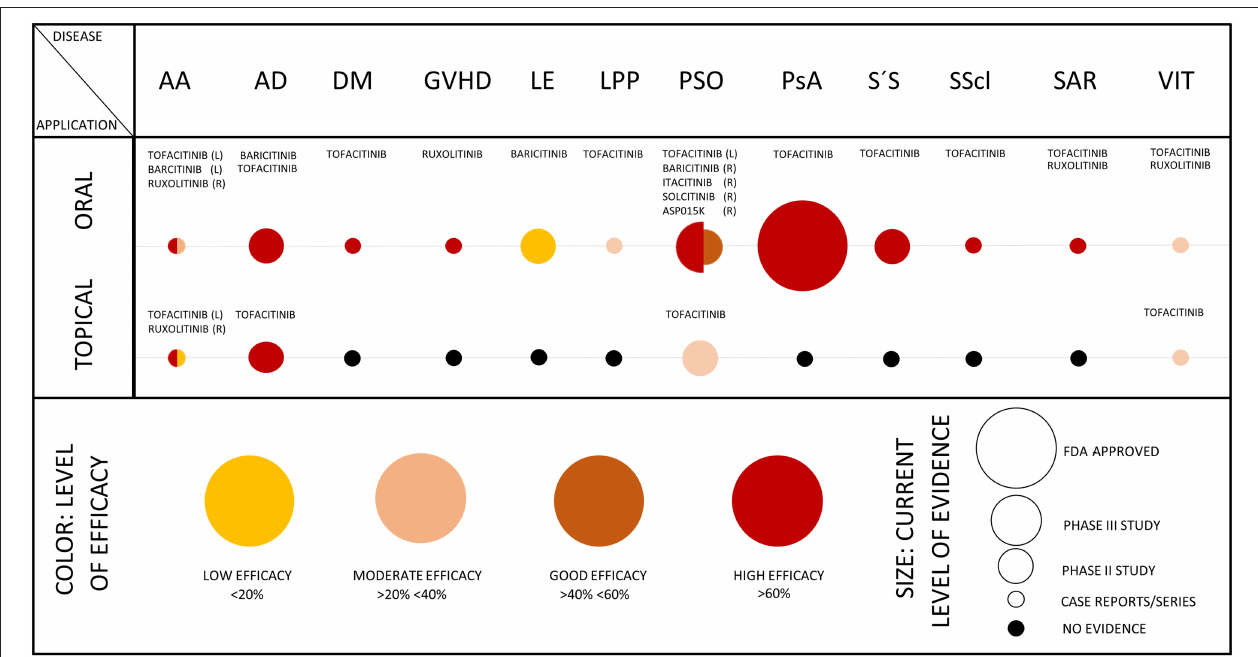
FIGURE 3 | Efficacy of JAKi in dermatology. The scheme summarizes the level of efficacy (as represented by colors) and the level of evidence (as represented by size of circles) in the indicated skin diseases. In diseases, where results from phase II/III studies are available as published, evaluation of JAKi in case series or single case reports was omitted. The scheme was adapted from Eyerich et al. ( 1). AA, alopecia areata; AD, atopic dermatitis; DM, dermatomyositis; GVHD, graft versus host disease; LE, lupus erythematosus (efficacy on skin lesions); LPP, lichen planopilaris; PSO, psoriasis; PsA, psoriasis arthritis; S’S, Sjögren’s syndrome; SScl, systemic sclerosis; SAR, sarcoidosis; VIT, vitiligo; (L), left; and (R), right half of the